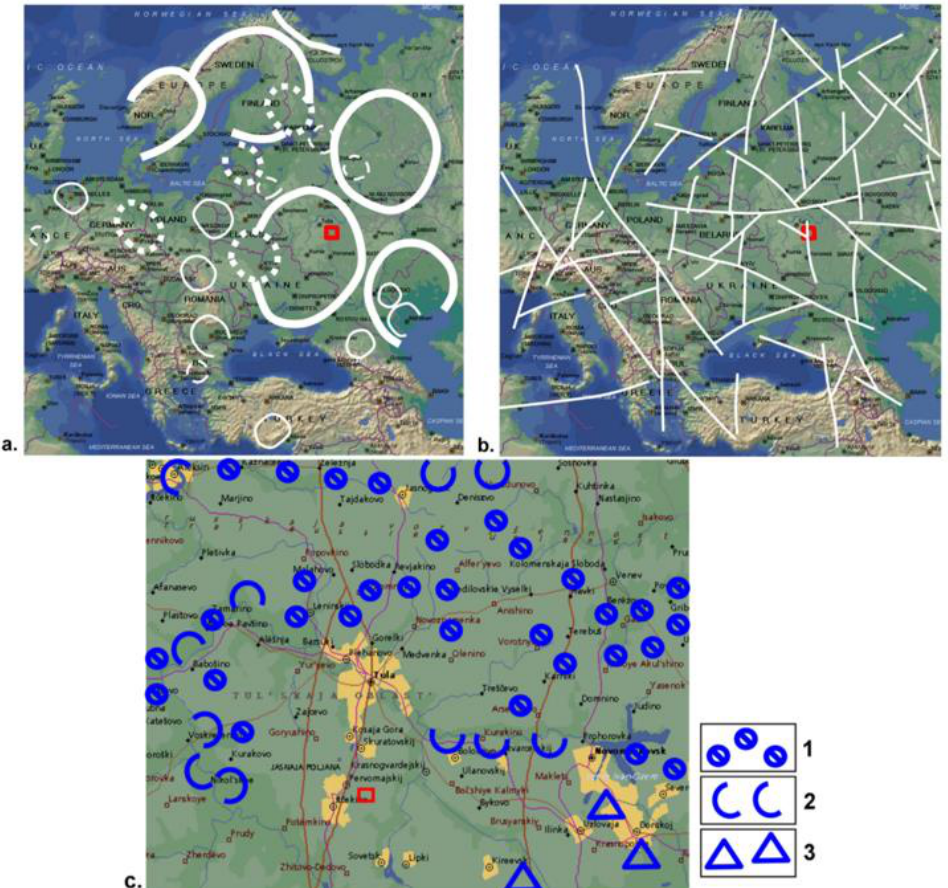
Figure 1. Geostructural position of investigated area (according to Brykhanov V.N., Boosh V.A., Chikishev A.G.): ( a ) schematic map of regional circular formations of the 1st – 4th orders within the contact of the East European Platform, West European Plate and Mediterranean belt; ( b ) schematic map of regional lineaments in the area of this contact. The approximate position of the estimated territory is marked by the red line; ( c ) the fragment of the regional map of geophysical engineering zoning of the Tula region and adjacent territories (according to Popov [13]) (1 — karst, 2 — landslide phenomena, 3 — areas of development of subsidence processes; area of interest is located slightly south with regard to the Tula, where the processes of karst formation and vertical subsidence in the upper part of the geological cross-section are also observed). One can see the area of interest has an anomalous position: at the regional scale — within a relic hot spot and on the intersection of geodynamic zones; at a large scale — in the vicinity of the river which is characterized by intensive landslide and karst formation.